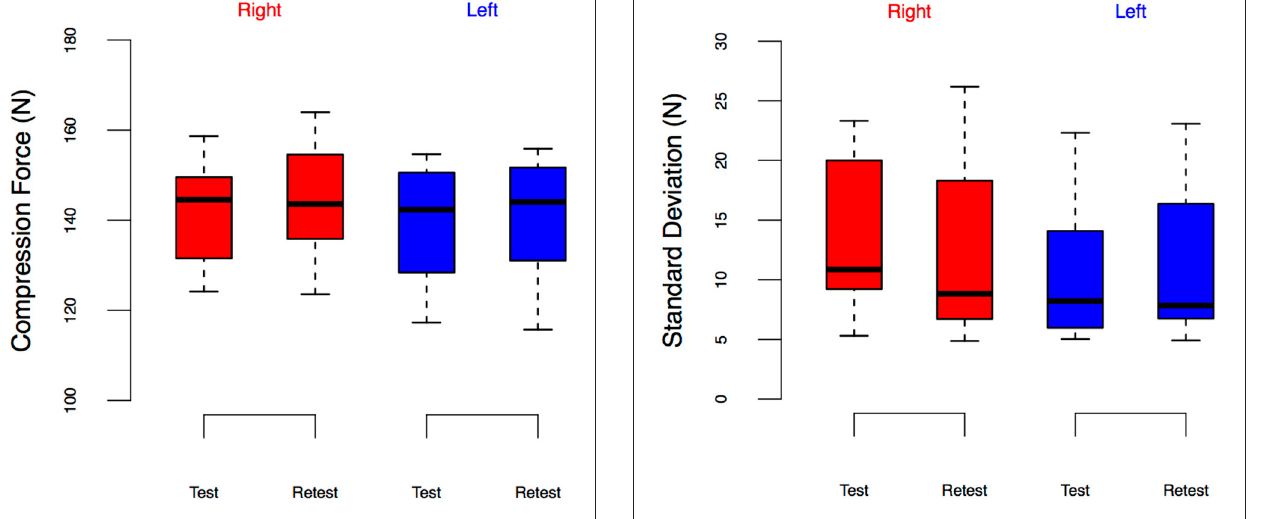
FIGURE 6 | LED force from the Test-Retest Control group. Group performance is shown as box plots. We did not observe leg-specific changes in LED force at retest.